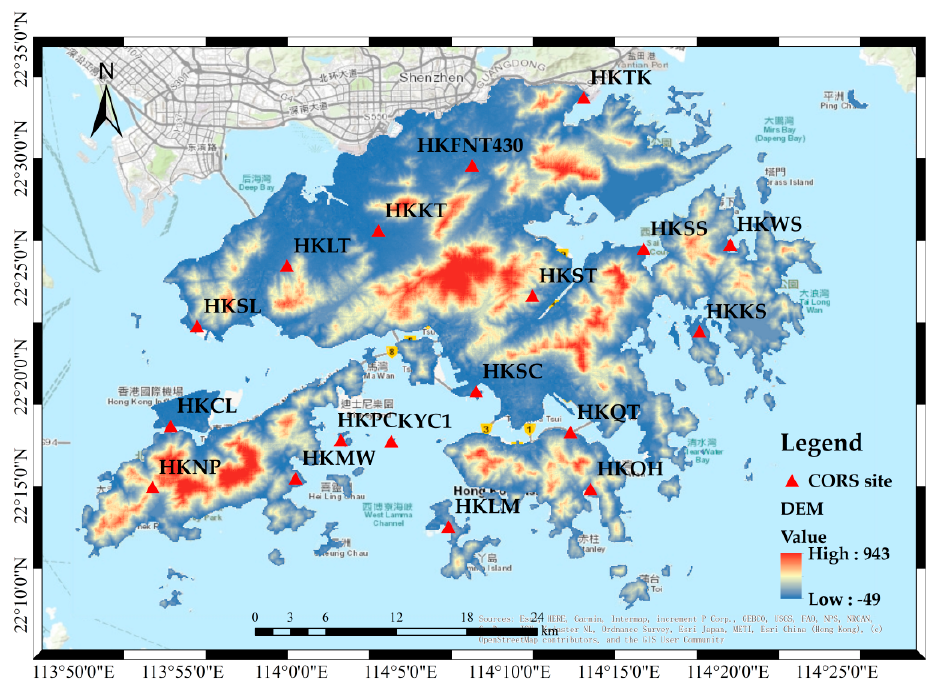
Figure 4. Distribution of CORS sites in Hong Kong (The bottom picture is labeled in English and Chinese).